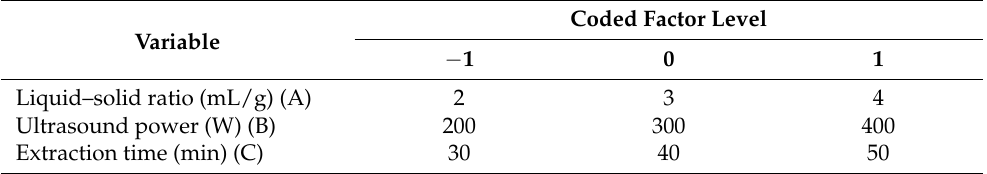
Table 1. Factors and level values of